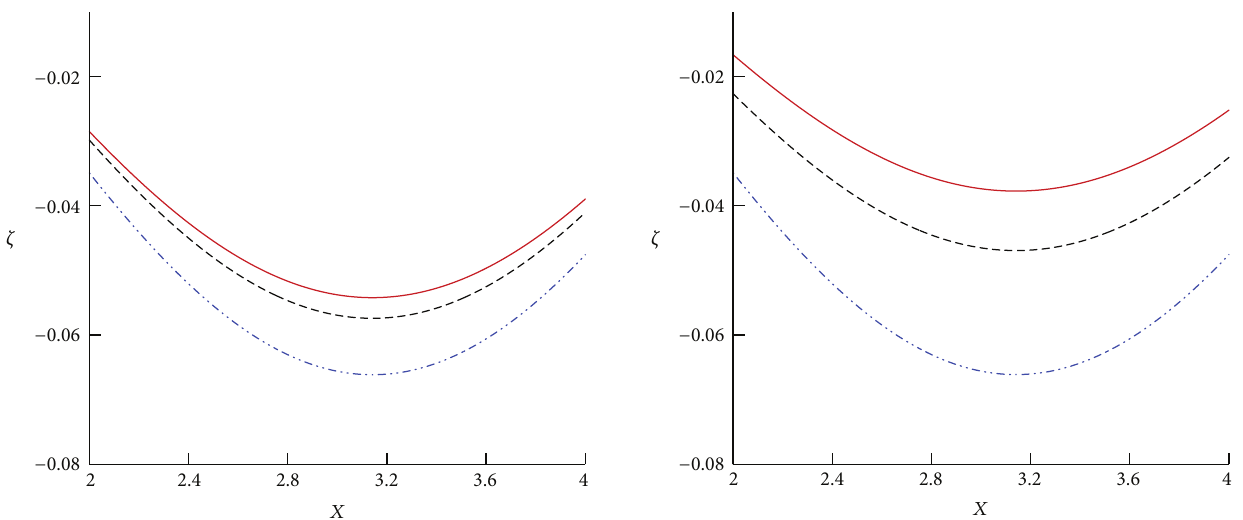
Figure 6: Variation of the plate deflection 𝜁(𝑋) near the trough versus 𝑋 for different Young’s moduli of the plate 𝐸 . Solid line: 𝐸 = 10 8 ; dashed line: 𝐸 = 10 9 ; dash-dot-dotted line: 𝐸 = 10 10 .